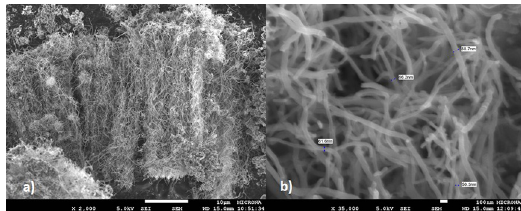
Figure 1. FESEM Micrographs: a) CNTs blocks, b) CNTs diameters.